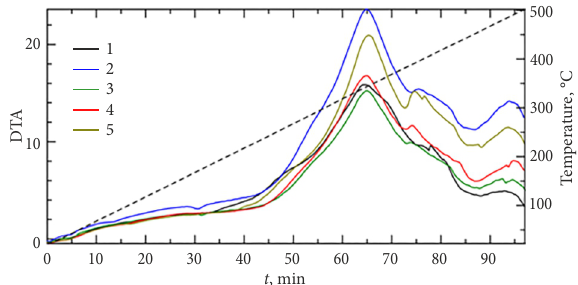
Fig. 4. DTG curves for GFRP rod elements